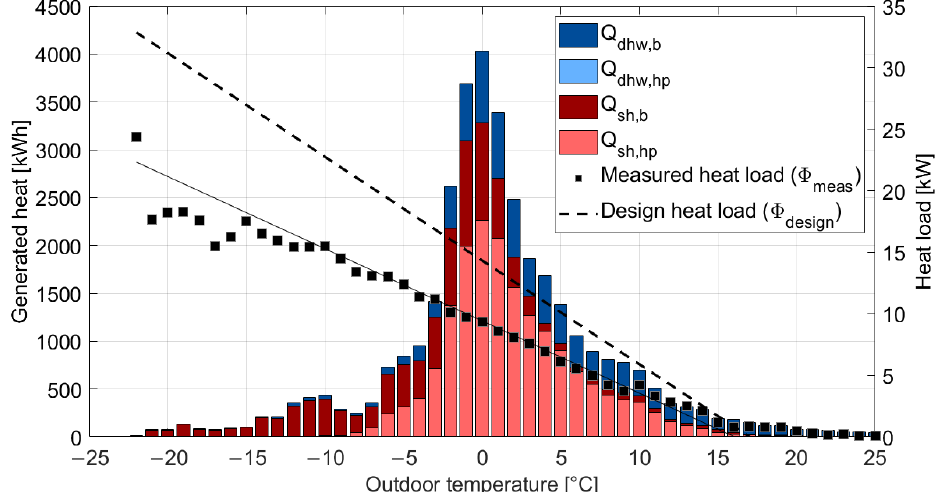
Figure 12. Provided heat from heat pump and boiler with the calculated and measured mean building heat